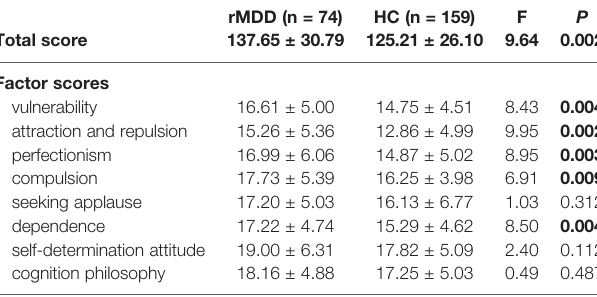
TABLE 3 | Comparison of the C-DAS-A total and factor scores in the rMDD subgroup and the HC